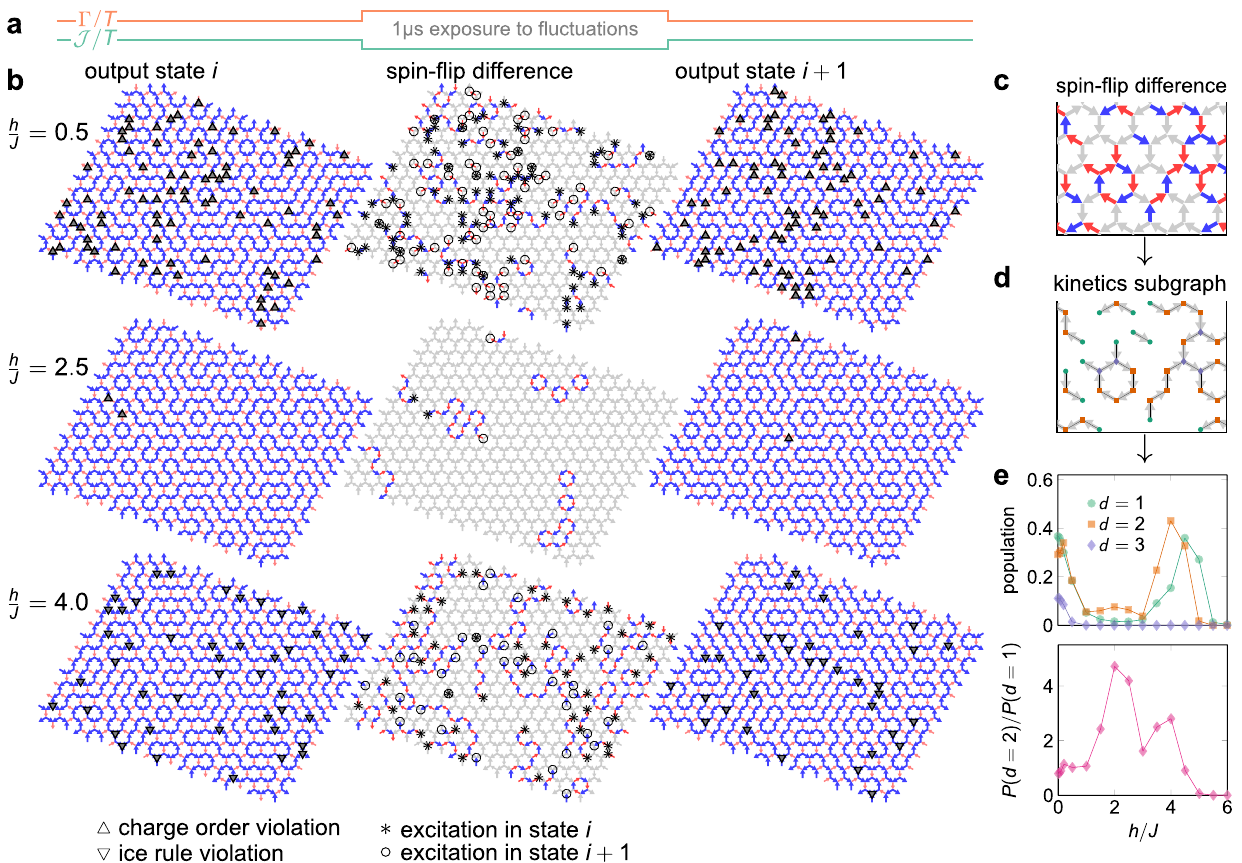
Fig. 4| Kineticsand fi eld-inducedtopologicalprotection.a Within thequantum annealer,thekineticsisdrivenbyareverseannealprotocolwhereinthequbits(Eq. (1)) are exposed to quantum fl uctuations ( Γ ) and thermal fl uctuations ð T = J Þ for a duration of 1 μ s between projected classical output states. b Quantum annealer outputsamples.Foreach h / J ,twoconsecutivestatesareshown,alongwiththespin- fl ip differencebetweenthem.Forthestates,up and downtrianglesdenotecharge- order violations and ice-rule violations, respectively. For the spin – fl ip differences, crossesdenoteexcitationsinstate i ,andcirclesdenoteexcitationsinstate i +1.For